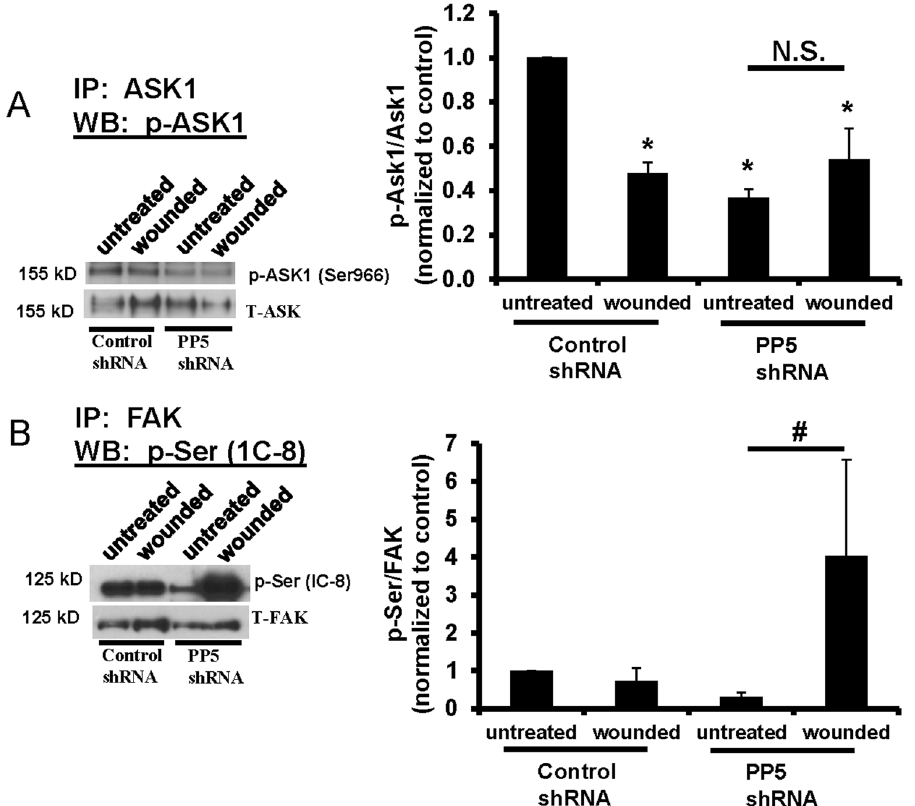
Figure 5. PP5 regulates the phosphorylation of FAK and ASK1 in wounded cells. Cell lysates from unwounded and wounded MLE-12 cells were collected after 24 hr, immunoprecipitated (IP) for FAK or ASK1, and then immunoblotted as indicated. Panel A Knockdown of PP5 using shRNA decreased p-Ser 966 -ASK1 in unwounded cells and showed no change in wounded cells. Panel B Knockdown of PP5 using shRNA caused a significant increase in p-Ser-FAK (recognized by the 1C8 antibody) in wounded cells. Right panels show the densitometry analysis normalized to unwounded controls. Asterisks ( * ) indicate a significant difference compared to control, (n = 4), p < 0.05. N.S. – no significant difference. Each set of bands shown was cropped from the same blot, and the full-length blots were provided in supplemental data. Each protein indicated was immunoblotted separately from independent